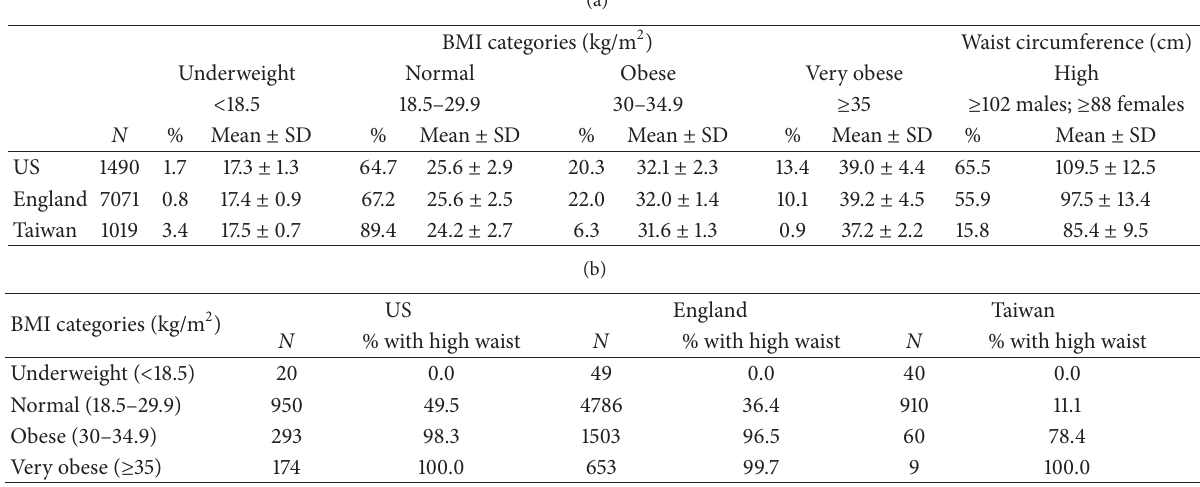
Table 2: (a) Distribution of body mass index (BMI) and waist circumference and mean BMI by BMI categories of high waist